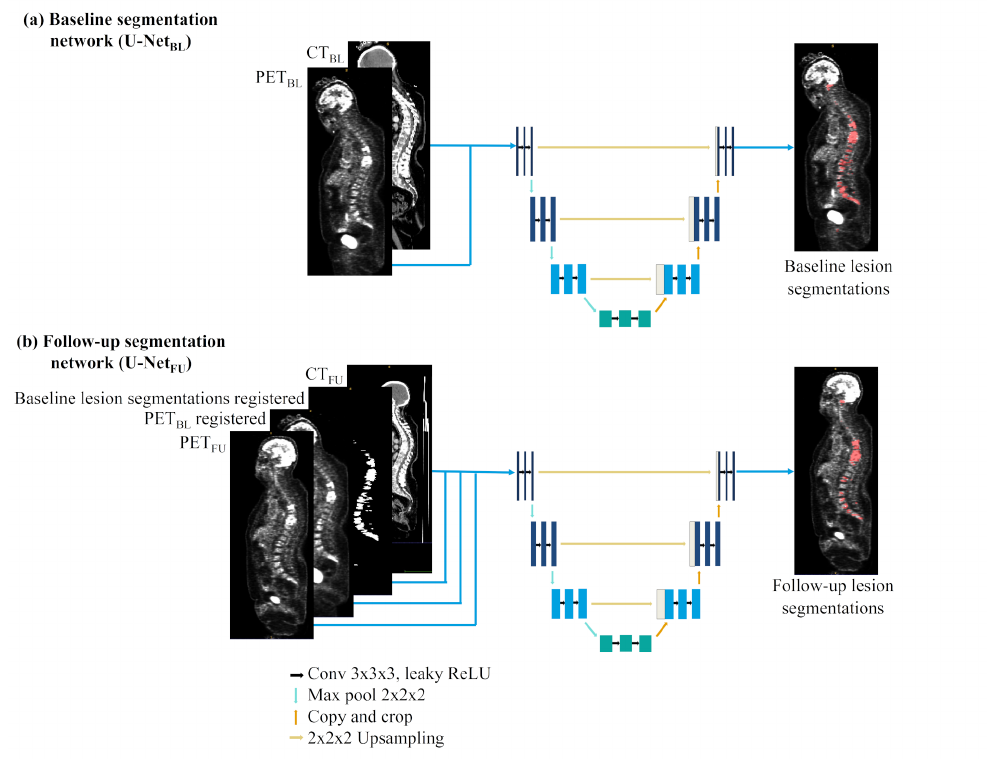
Figure 1. ( a ) U-Net BL and ( b ) U-Net FU networks’ architectures and inputs. Baseline segmentation network (U-Net BL ): With the U-Net BL network only baseline images were used for training. The trained network was then validated on the 60